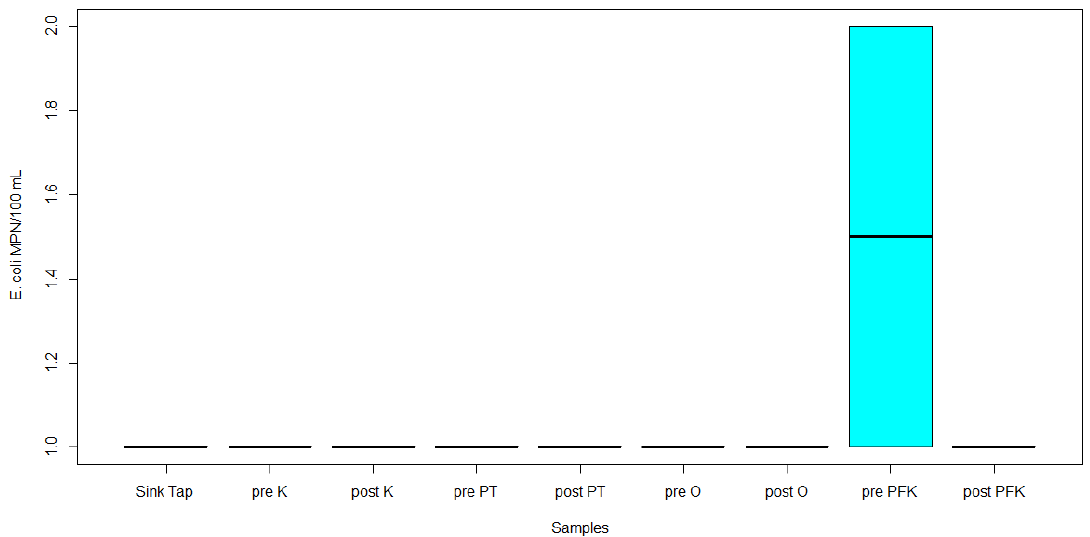
Figure 2. IDEXX Escherichia coli MPN/100 mL concentrations in collected samples (outside (O), inside kitchen (K), pressure tanks (PT), and post-filtration kitchen tap (PFK).